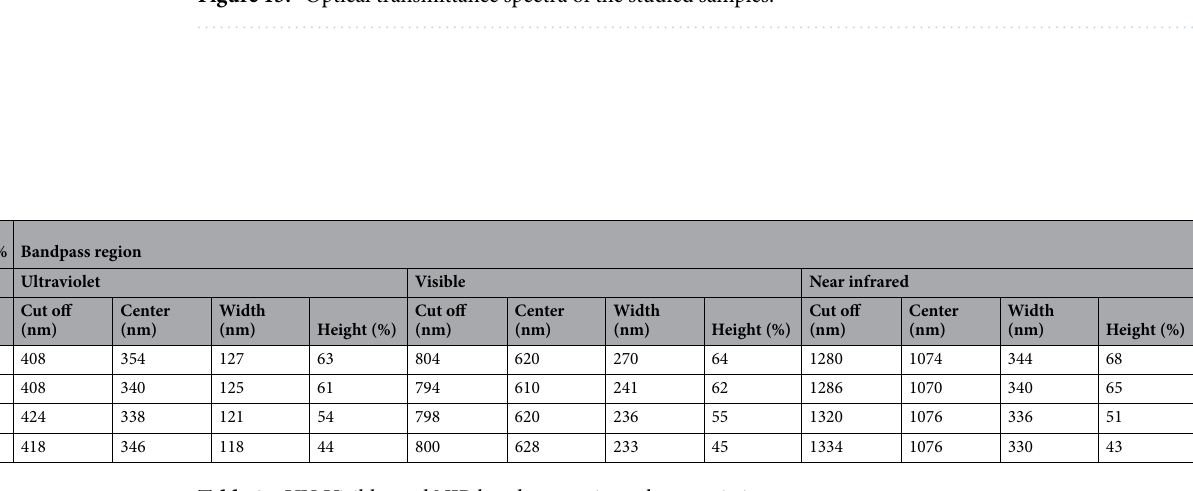
Table 2. UV, Visible, and NIR bandpass regions